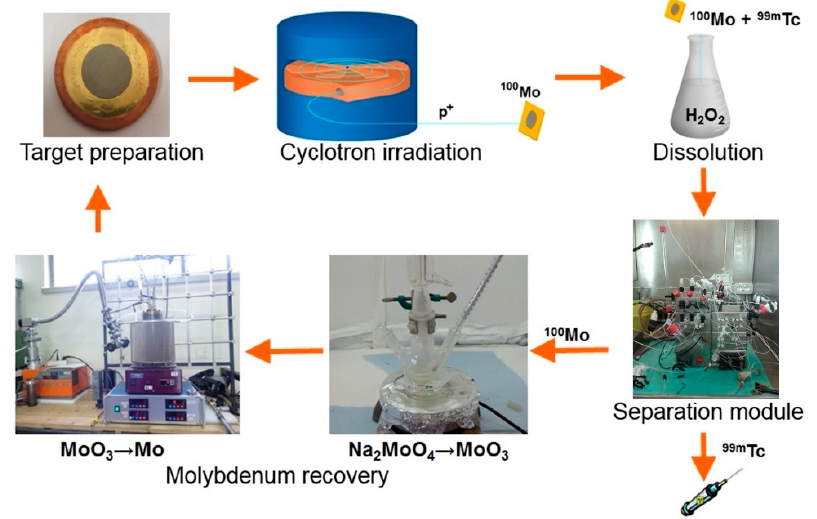
Figure 1. TECHnetium direct-production in hOSPital (TECHN-OSP) 99m Tc production cycle.